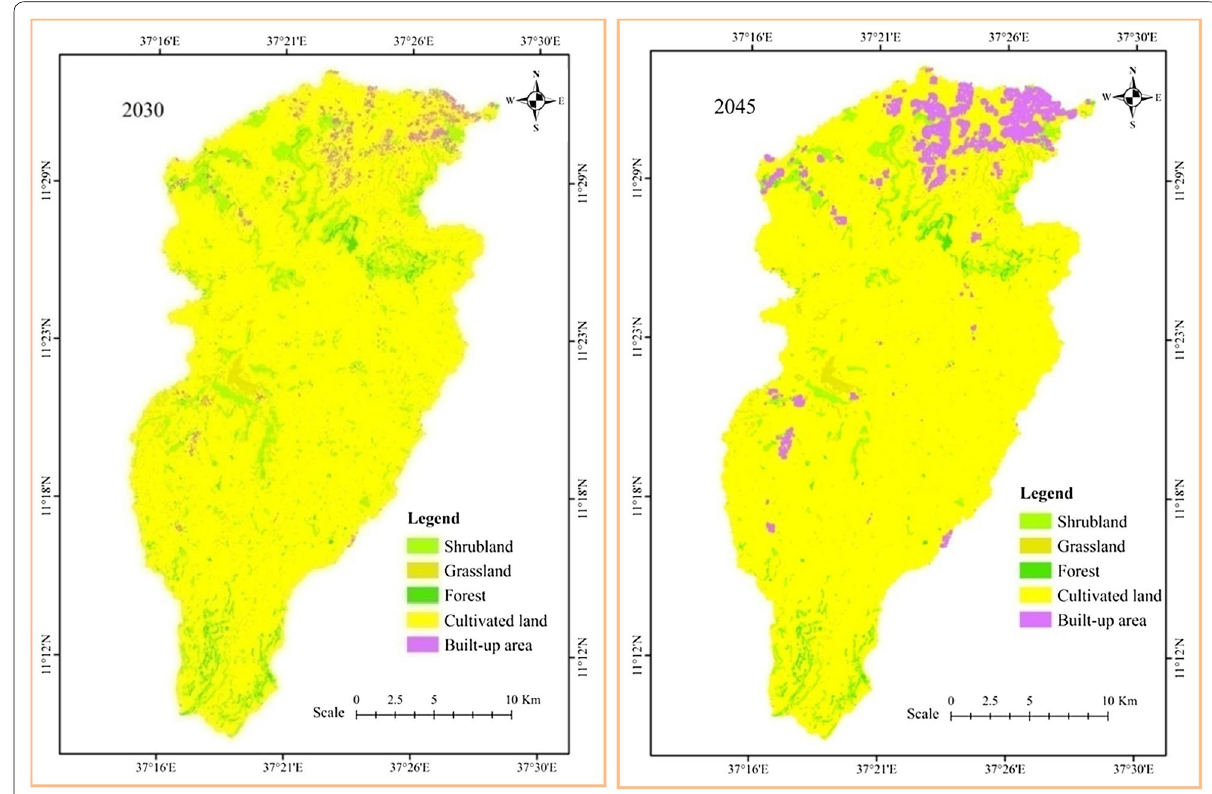
Fig. 5 The 2030 and 2045 land use/land cover of the Andassa watershed